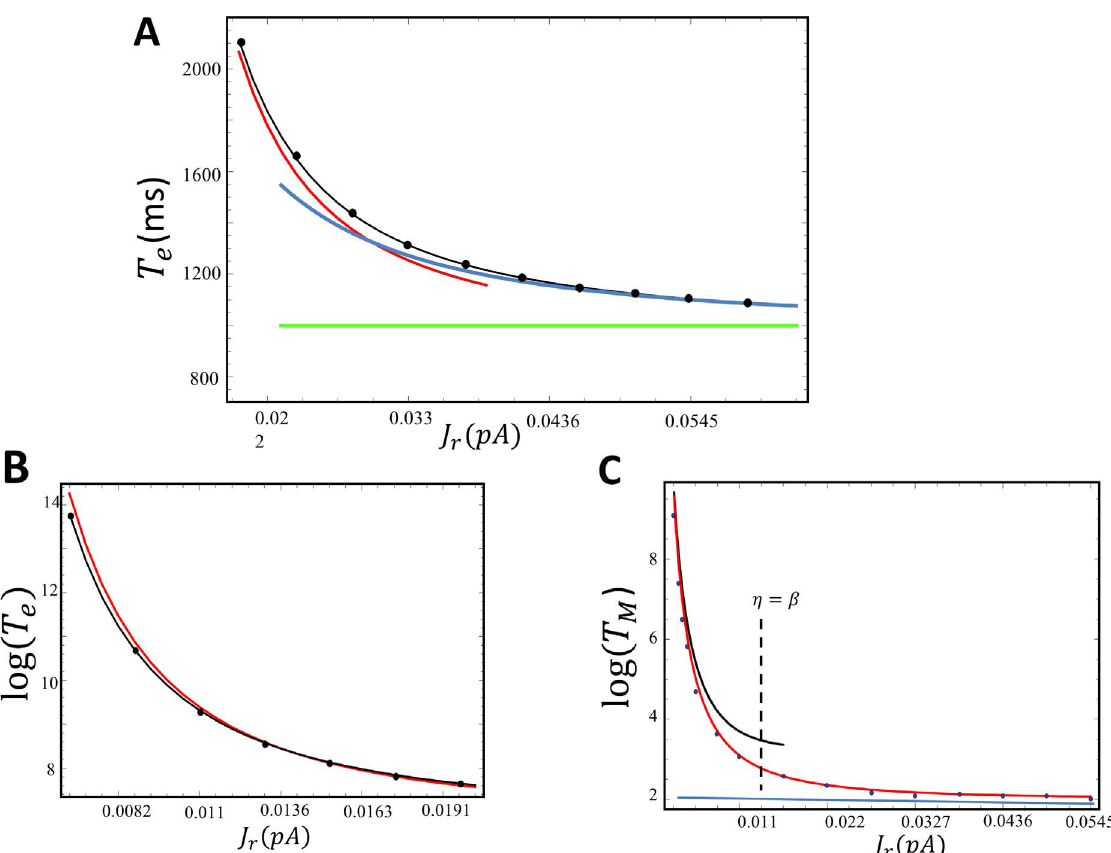
Figure 3. (A) Plot of T e vs the RyR single channel current J r . The curves shown are numerical solution using the exact stochastic algorithm (black circles), exact solution (black line) according to Eq. (11), asymptotic solution valid in regime II Eq. (12) (red line), high excitability limit using Eq. 13 (blue line), and finally the MFPT for a single channel opening given by Eq. (14) (green line). Here, we fix k z ~ 10 { 3 ( m M ) { 2 ms { 1 and N ~ 100 . (B) Plot of log T e ð Þ vs J r for small J r for the same parameter choice as Fig. (3A). Black circles are numerical simulation results, black line is the exact solution using Eq. (11) and the red line is the asymptotic solution given by Eq. (12). (C) Plot of log T M ð Þ vs J r using b ~ 1 = 13 : 6 and M ~ 100 . To speed up simulations we have used k z ~ 10 { 2 ( m M ) { 2 ms { 1 . Black circles are the numerical simulation results, the red line is computed using the summation shown in Eq. (24). Black line is the asymptotic approximation evaluated via Eq. (27) and the horizontal blue line is the high excitability limit given by Eq. (23). The vertical dashed line indicates the current J r where g ~ b .